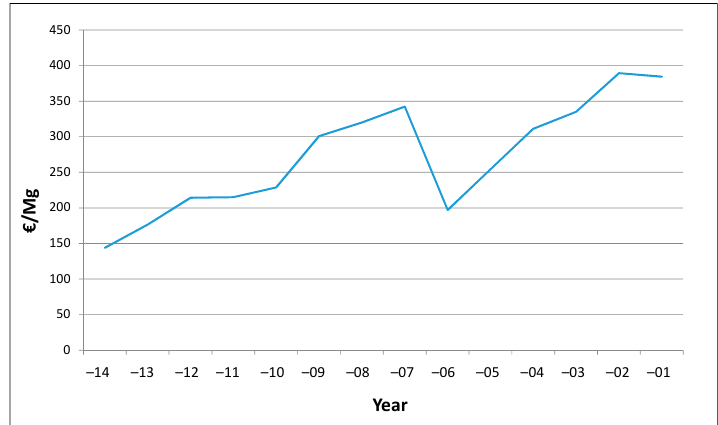
Figure 3. Wholesale electricity prices (nominal values) (source: [41]).